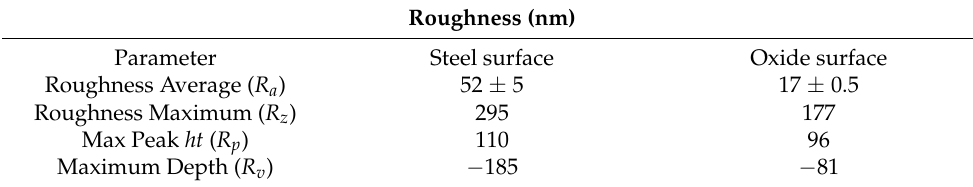
Figure 3. ( a , b ) laser scanning confocal microscopy (LSCM) surface micrographs observation, and topographic atomic force microscopy (AFM) image (3D view) of the ( c ) initial surface and ( d ) the oxide layer growth on maraging 300 alloy. Table 2. Summary of the main roughness parameters for the reference sample and the oxide layer.